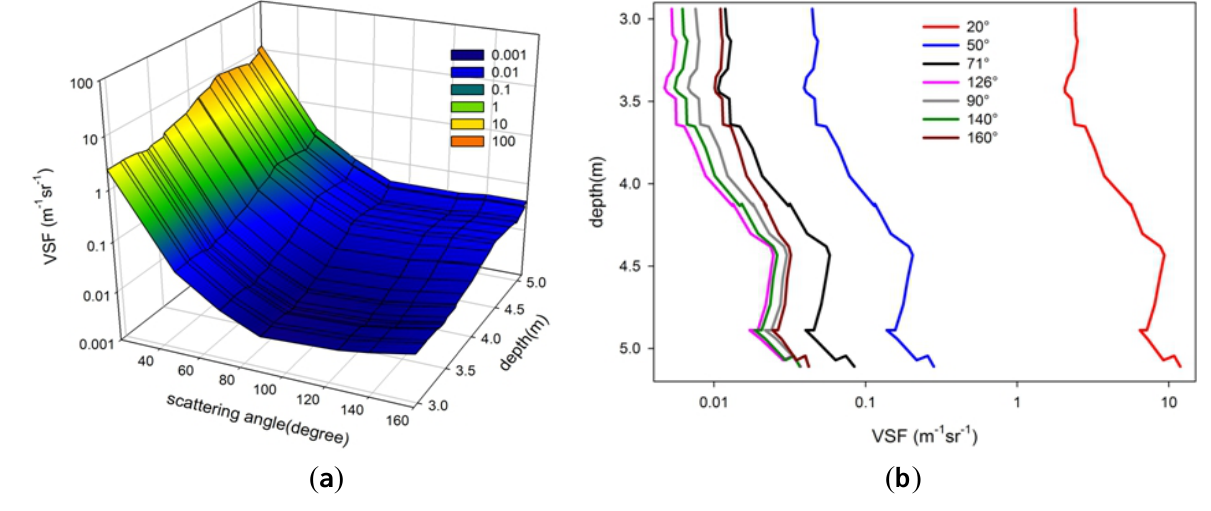
Figure 11. The distribution of the profile and the angle of the VSF (station A, inshore, 22°56 ′ N, 114°52 ′ E). ( a ) shows the three-dimensional distribution of the VSF with profile and angle; ( b ) shows the distribution characteristics of the VSF with profile at different